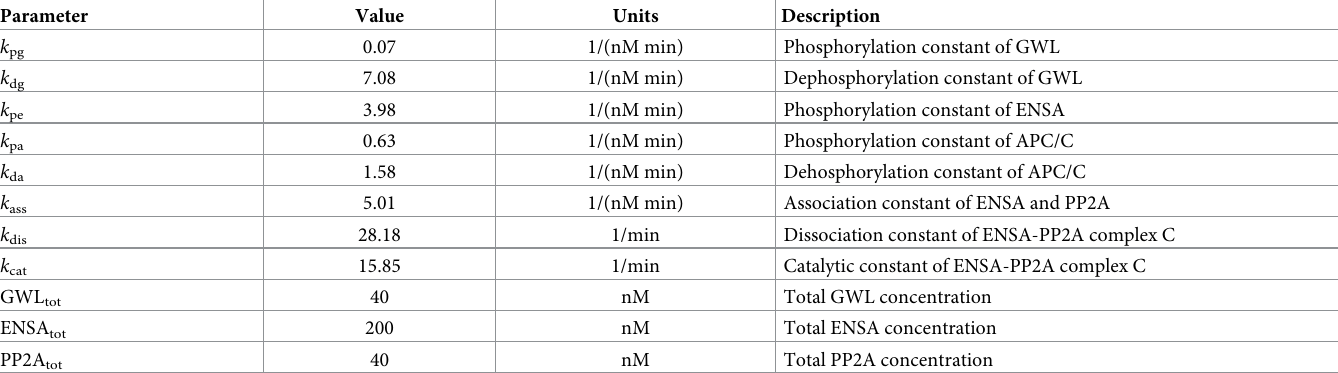
Table 1. Default parameter values for the mass-action model of the PP2A-ENSA-GWL network.